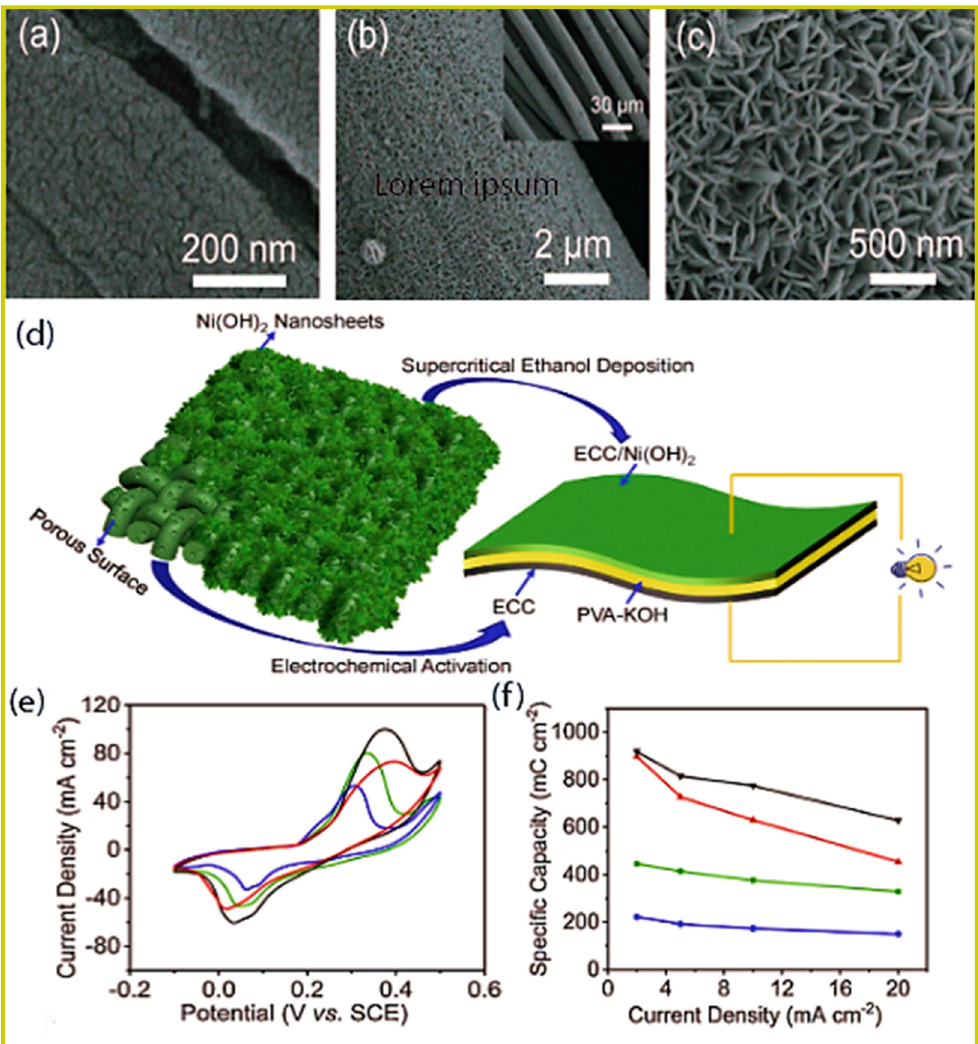
Figure 15. SEM image of the porous surface of electrochemically activated carbon cloth (ECC). ( a ), SEM images of ECN-3 composite electrode material (the top inset signifies the top-view image of the free-standing electrode at low-resolution mode). ( b ), SEM image of the compact gown nanosheets (NSs) with a distinct open porous structure. ( c ), the graphical illustration of the flexible ASC using ECN-3 and ECC electrodes. ( d ), CVs of various Ni(OH) 2 NSs/ECC electrodes at 20 mV.s − 1 . (The samples were fabricated with various amount of nickel nitrate hexahydrate (0.1 g, 0.2 g, 0.3 g, and 0.4 g), and named ECN-1, ECN-2, ECN-3, and ECN-4, respectively. ( e ) Specific capacities of the ECN electrodes at various current densities. (blue line: ECN-1, green line: ECN-2, black line: ECN-3, red line: ECN-4) ( f ). Reprinted with permission from [84], Copyright 2020, Elsevier.